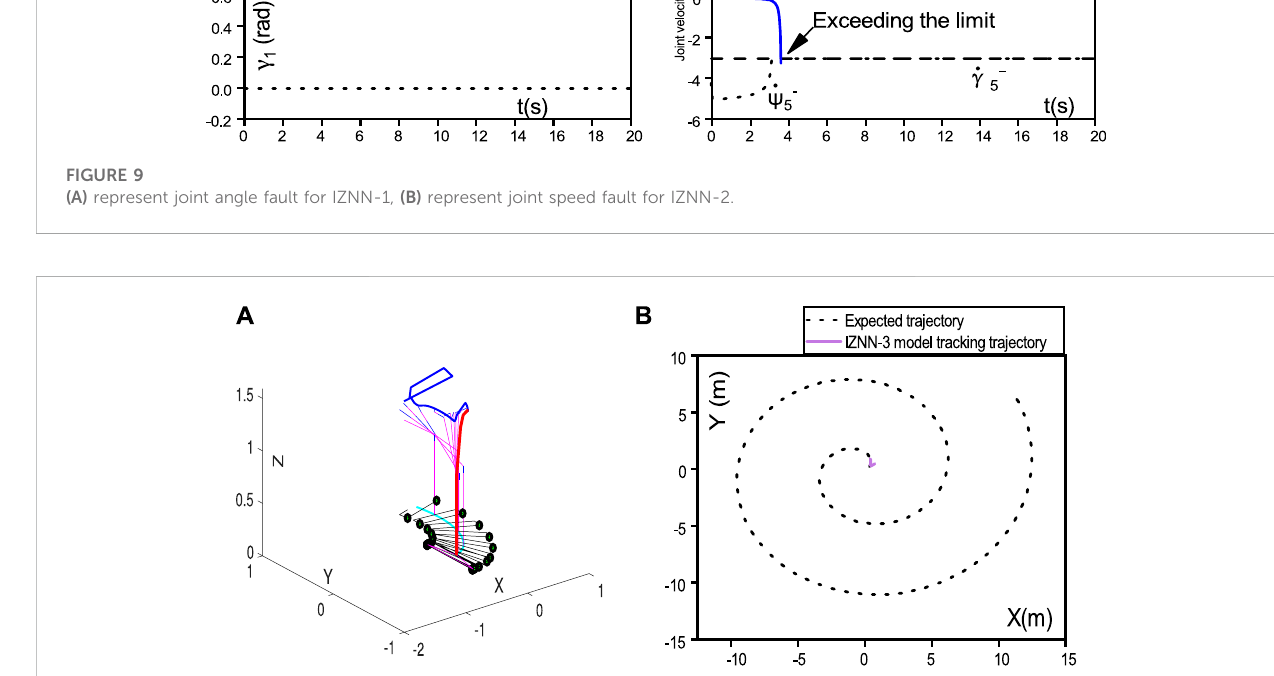
FIGURE 10 (A) represent IZNN-3 model-controlled wheeled robot's joint trajectory, (B) represent the end-effector